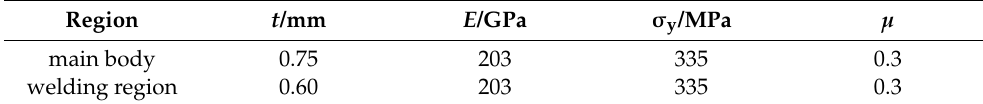
Table 3. Thickness and material properties of the spherical shell.